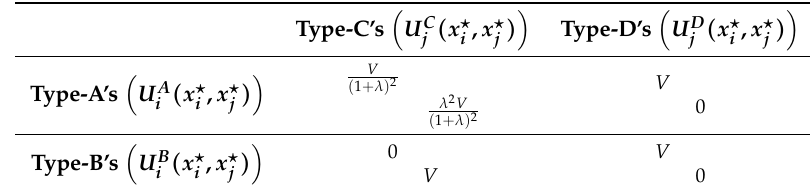
Table 2. Individual match and maximized